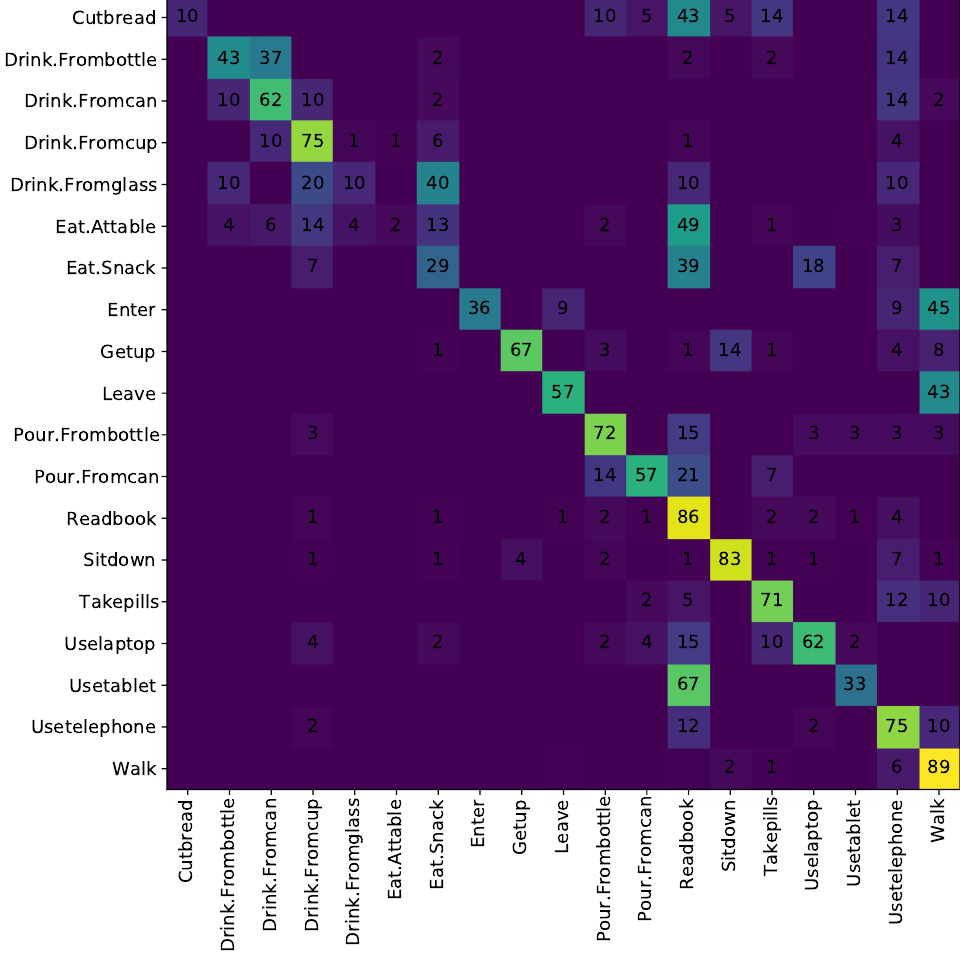
Figure 5. Confusion matrix (in %) for the best cross-view separable STA result (‘Both,